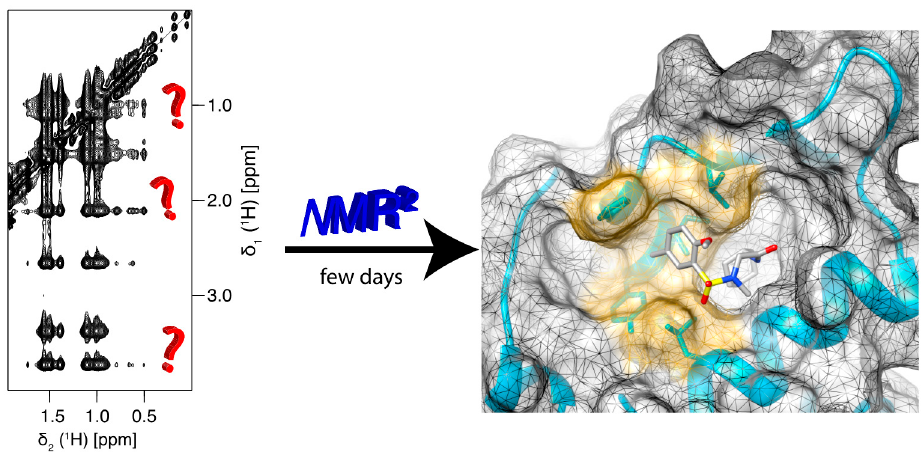
Figure 1. Nuclear Magnetic Resonance Molecular Replacement ( N MR 2 ) derives the complex structure of the binding site within a few days without protein resonance assignment and using only standard 2D NMR experiments.